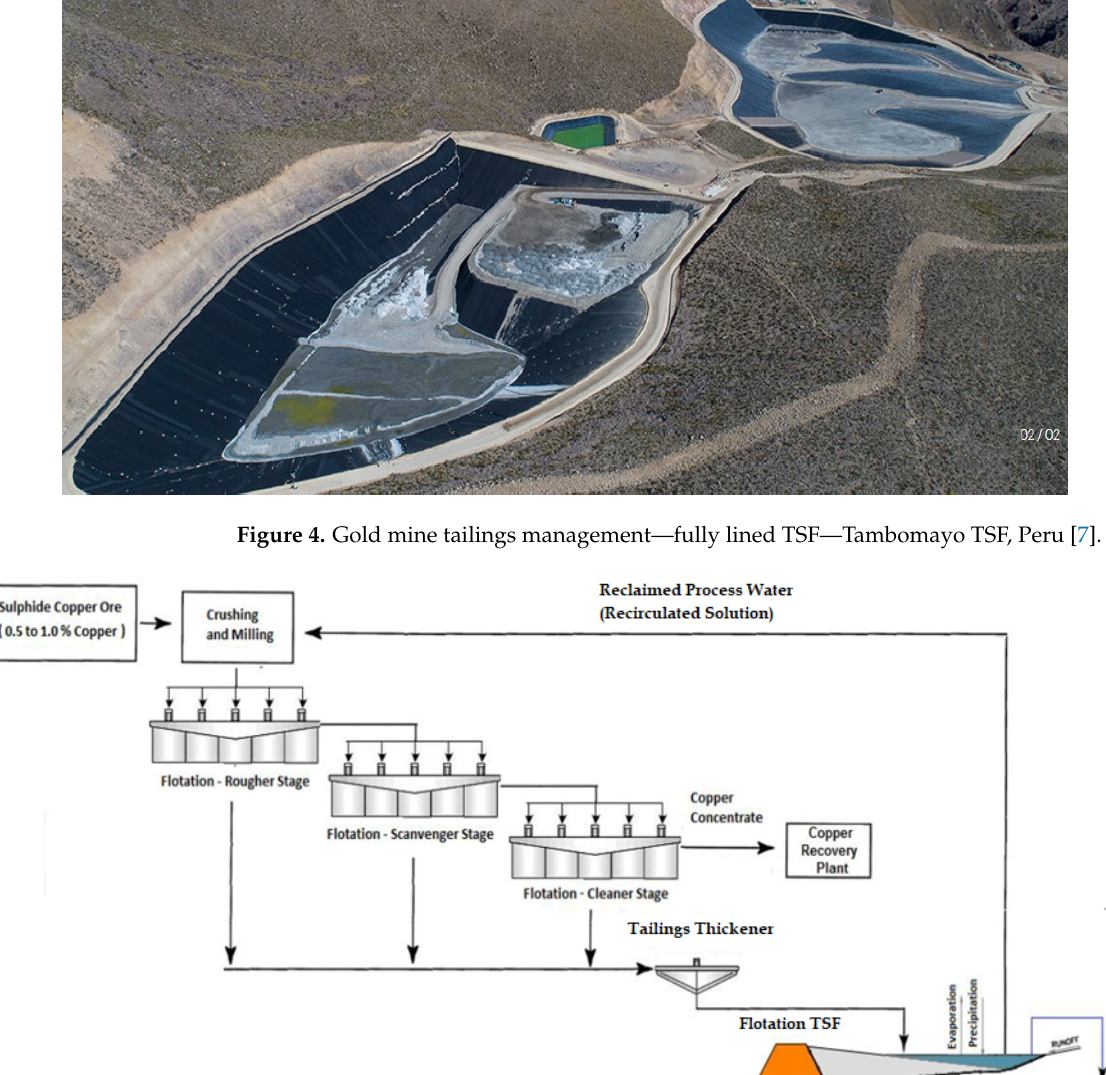
Figure 4. Gold mine tailings management—fully lined TSF—Tambomayo TSF, Peru [7].